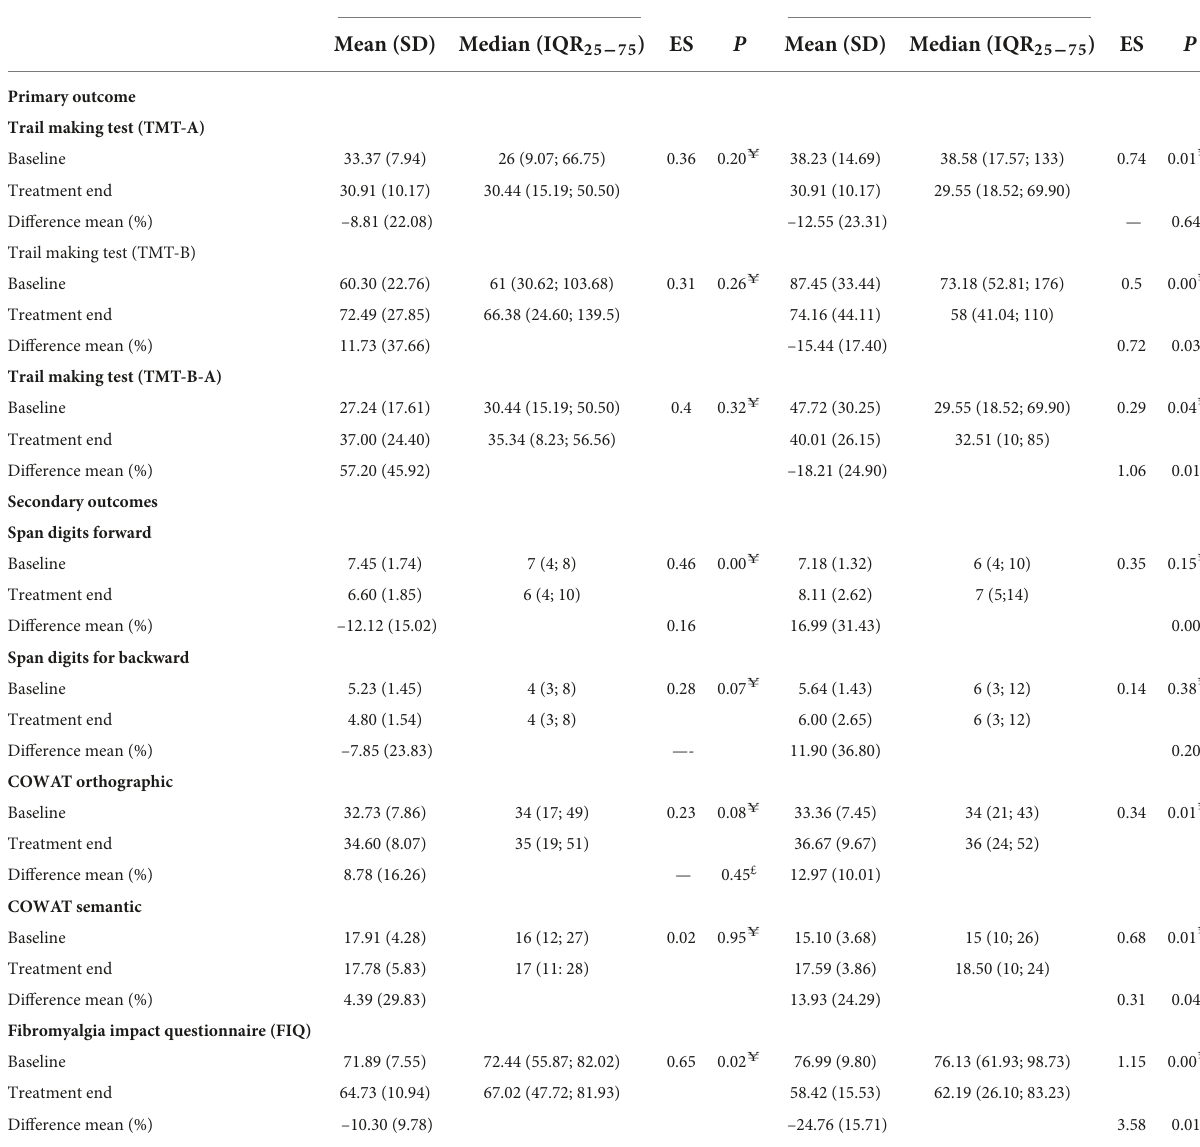
TABLE 2 Univariate analysis: Interventions effects within and between groups on primary and secondary outcomes ( n =